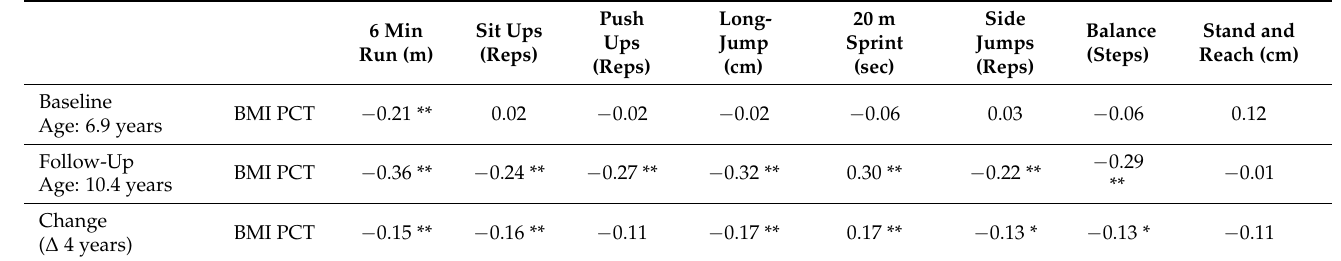
Table 2. Association between body weight and physical fitness at baseline and last follow ‐ up, and between change in body weight and change in physical fitness. Values are Pearson correlation coefficients.